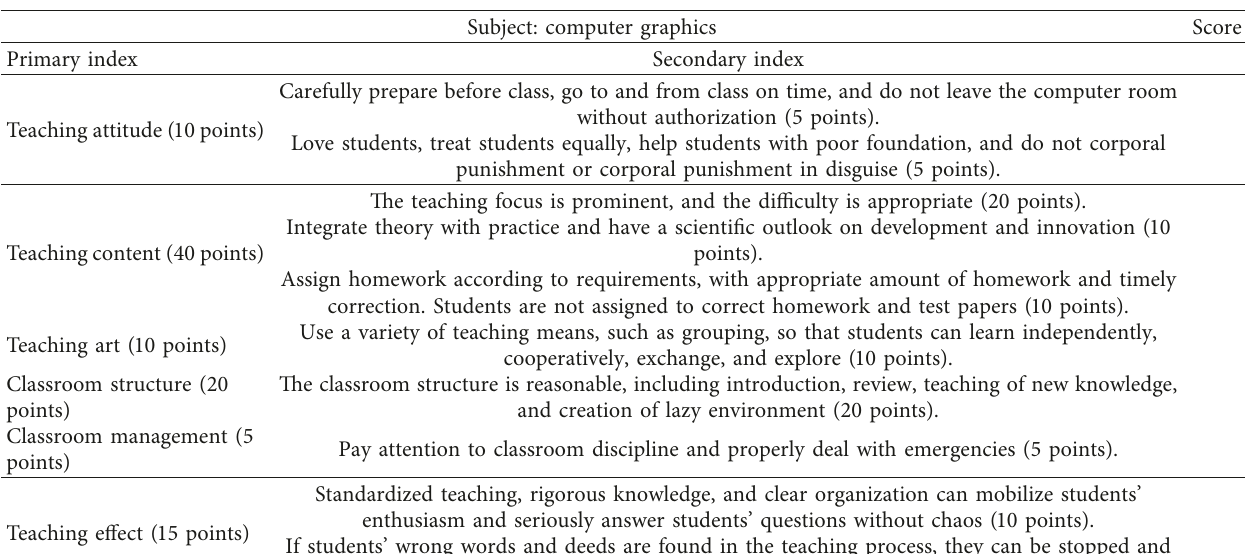
Table 11: Teaching evaluation index set.